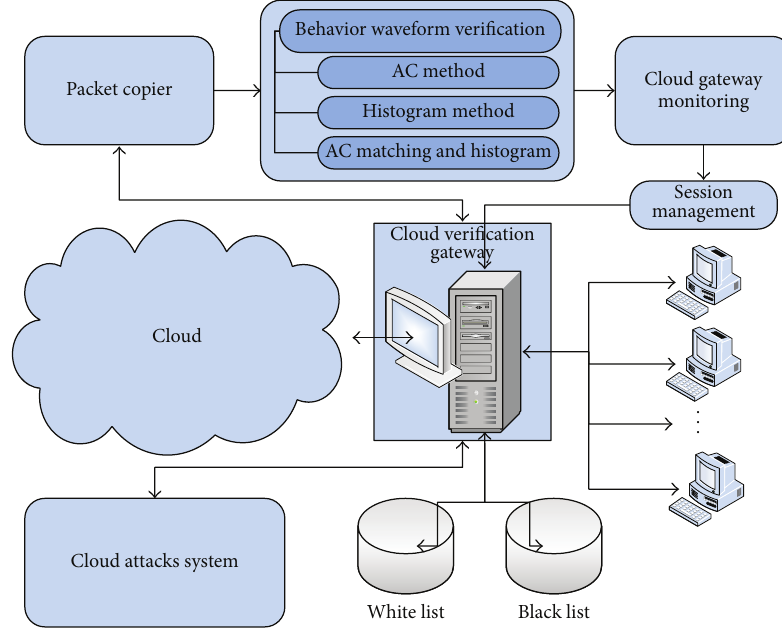
Figure 9: Diagram of evaluation environment.